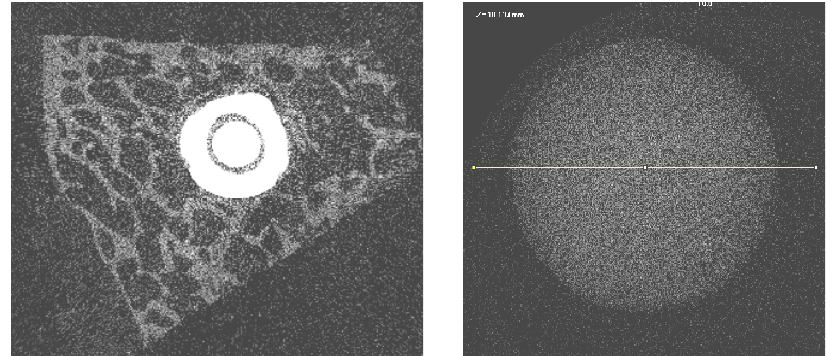
Figure 1. µCT images of (a) Ti implant in bone (middle portion) (b) Teflon block (100% beam hardening correction at 1.2 rotation steps of 180º